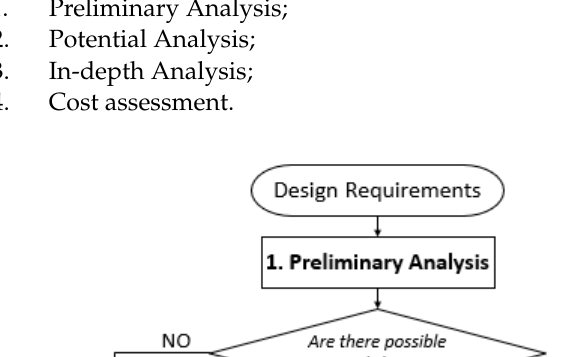
Figure 2. Example of timeline for a common design process involving additive technologies in the field of machined parts.